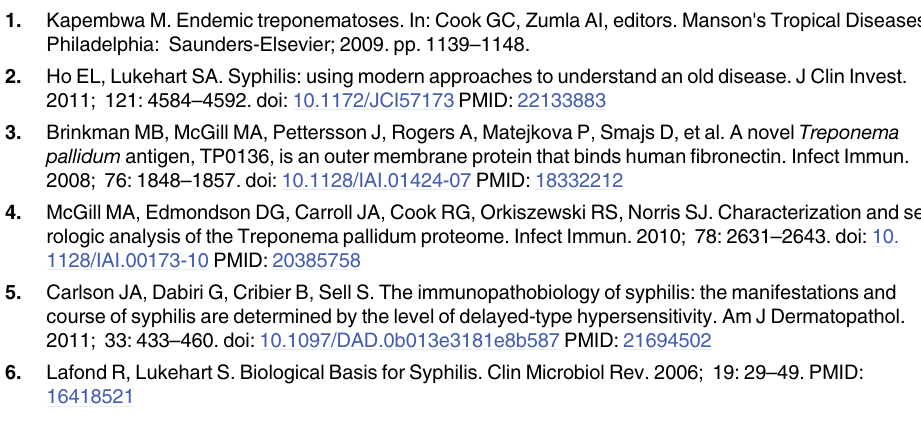
S1 Table. Individual-based dataset on clinical manifestations, molecular and serological test results. S2 Table. Comparison of NTT results from serum and plasma samples of